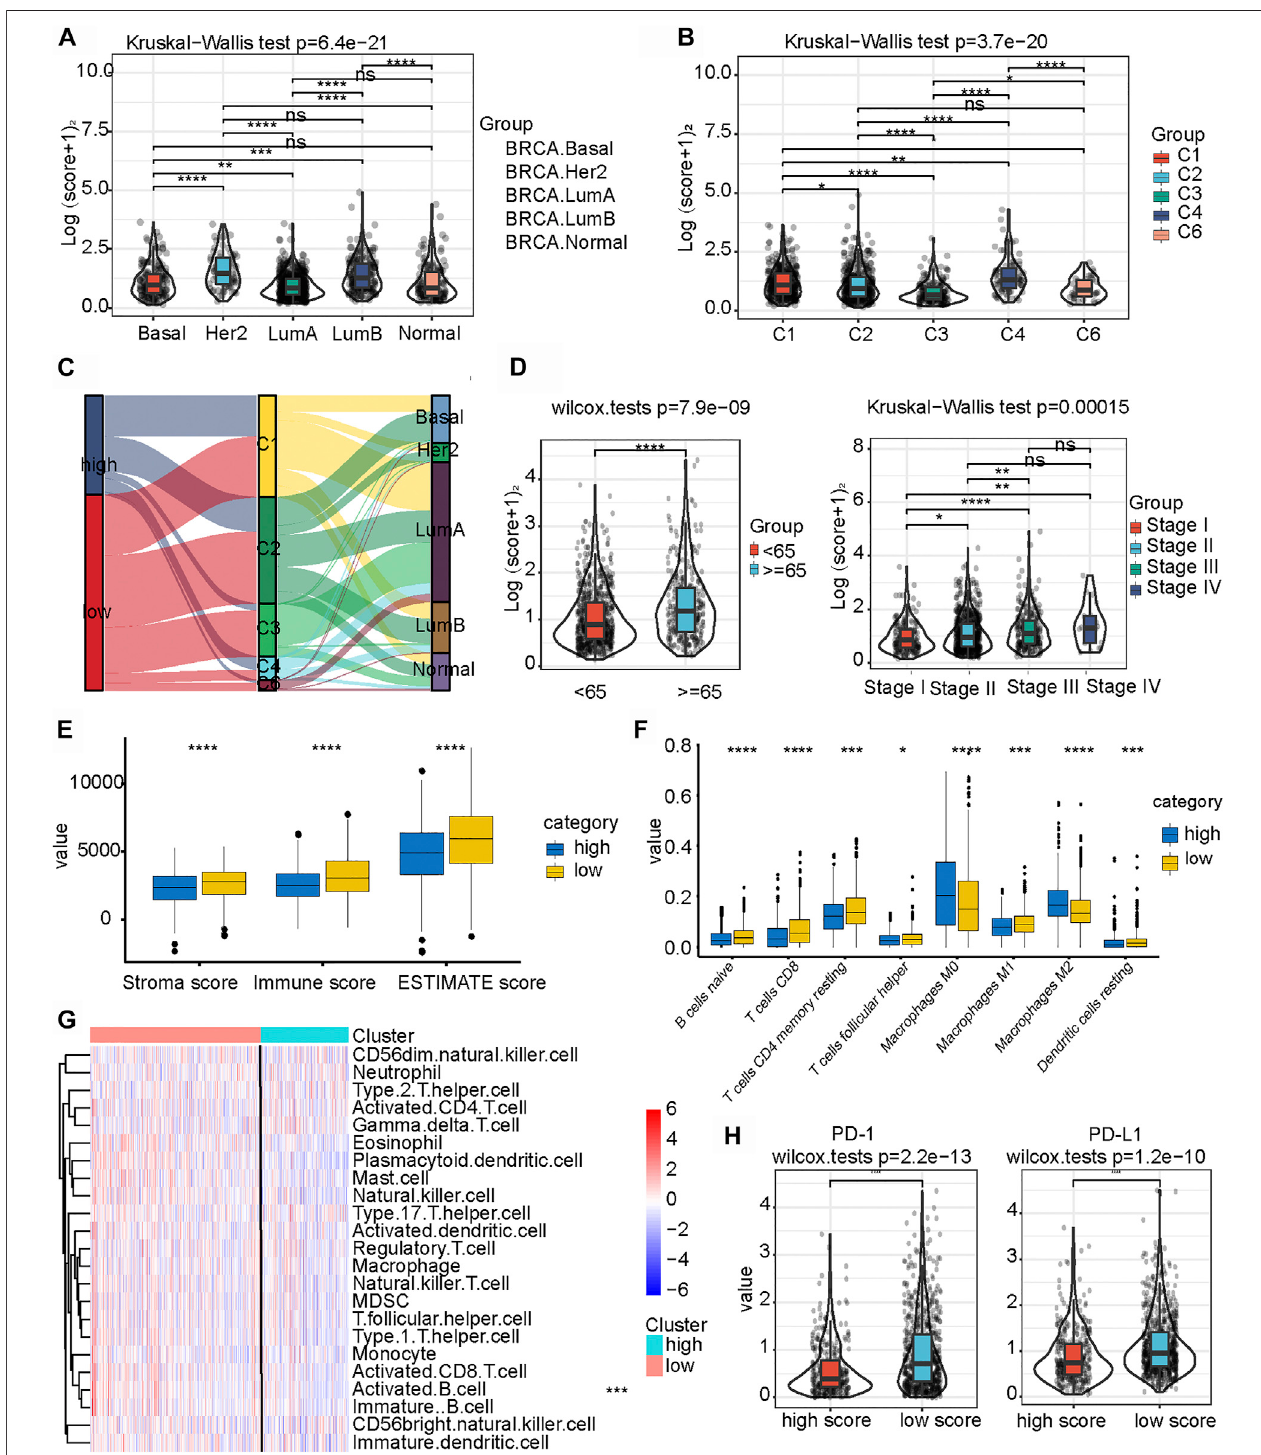
FIGURE 4 | Relationship between clinicopathological characteristics and the N 6 -methyladenosine-related immune score (m6A-IS). (A) Difference in m6A-IS in breastcancer withdifferent molecular subtypes. Statisticaldifference indifferentbreast cancermolecularsubtypes wascompared bythe Kruskal – Wallis test (* p < 0.05; ** p < 0.01; *** p < 0.001). (B) Difference in m6A-IS between different immunogenomic subtypes. The Kruskal – Wallis test was performed to compare the statistical difference in each immunogenomic subtype (* p < 0.05; ** p < 0.01; *** p < 0.001). (C) Alluvial diagram representing the association of m6A-IS, six immune subtypes,andclinicalmolecularsubtypesinbreastcancer. (D) Breastcancerpatientswithdifferentclinicopathologicalfeatureshaddifferentexpressionlevelsofm6A-IS